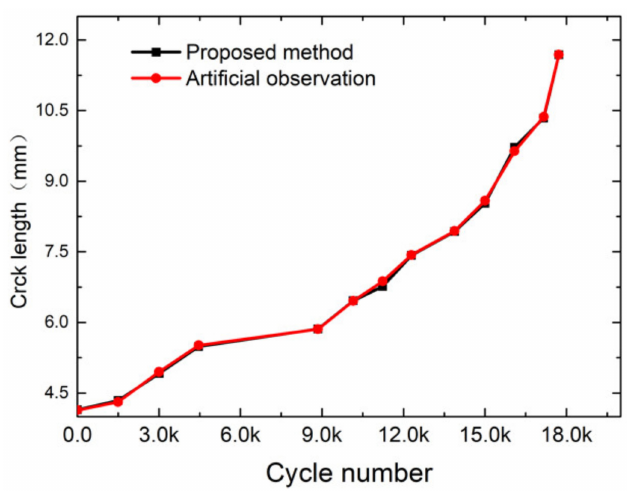
Figure 19. Crack length measurement results over fatigue experiments.